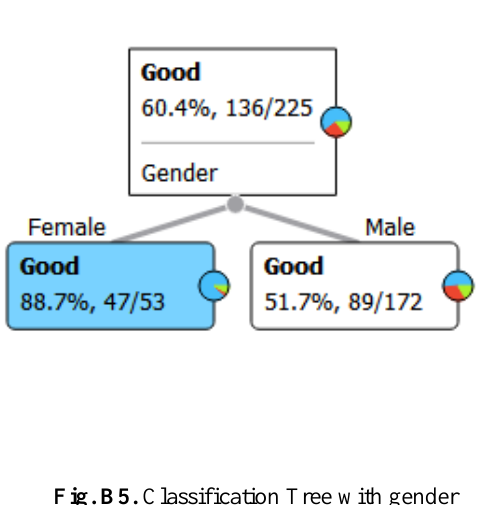
Fig. B5. Classification Tree with gender